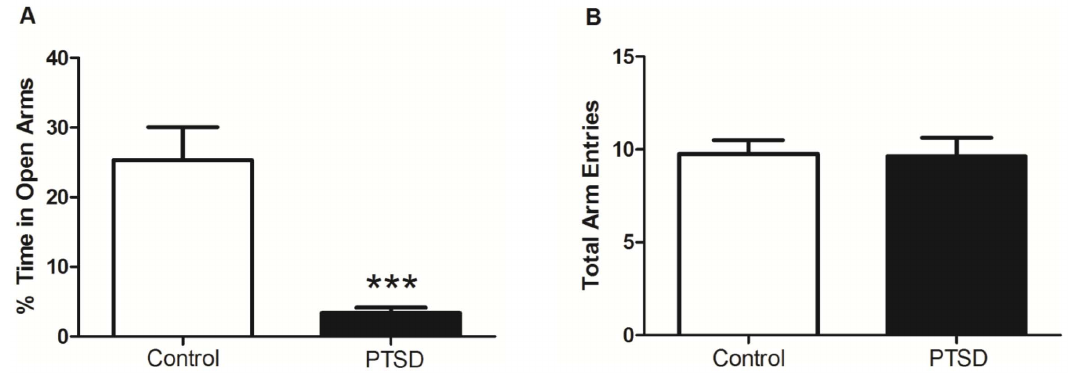
Figure 3. Elevated plus-maze performance. The PTSD group displayed significantly higher anxiety than the control group, as evidenced by their reluctance to spend time in the open arms of the EPM (A). Total ambulations, however, were essentially equal between the two groups (B). Anxiety on the EPM was tested within 24 hours of the final day of the 31-day stress regimen. Data are presented as mean 6 SEM. ***p , 0.0001 relative to the control group.